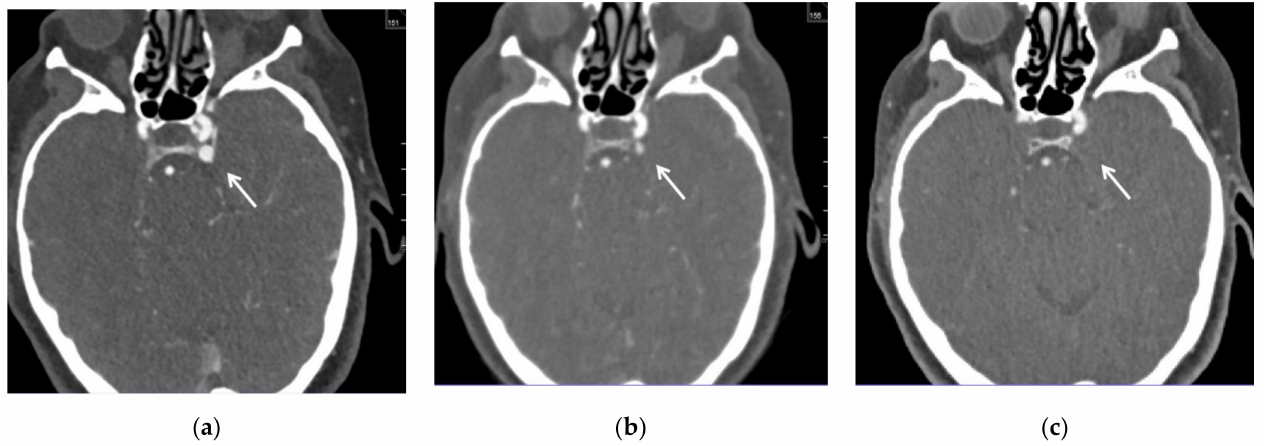
Figure 5. CT angio on admission ( a ) and at 3 ( b ) and 6 ( c ) month follow-up. The venous pouch at the posterior aspect of the left cavernous sinus (white arrow) progressively decreased in size and